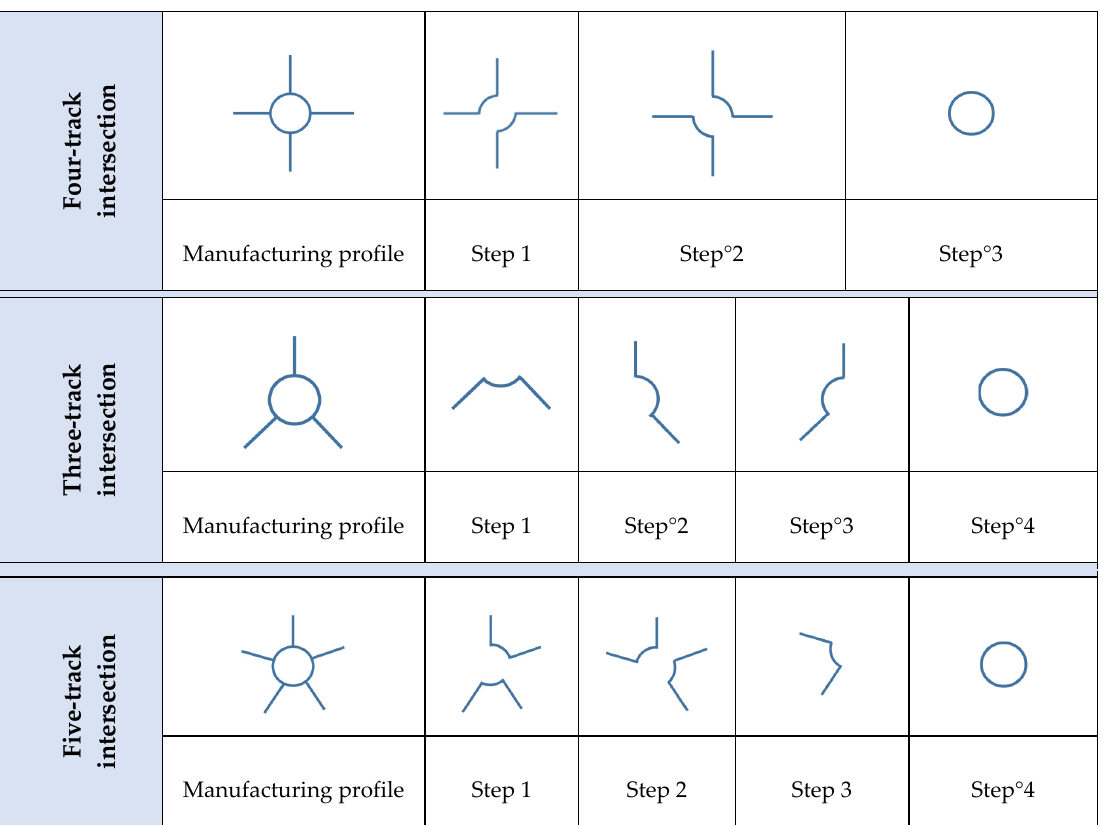
Figure 10. Multiple track intersection crossing with the proposed method.